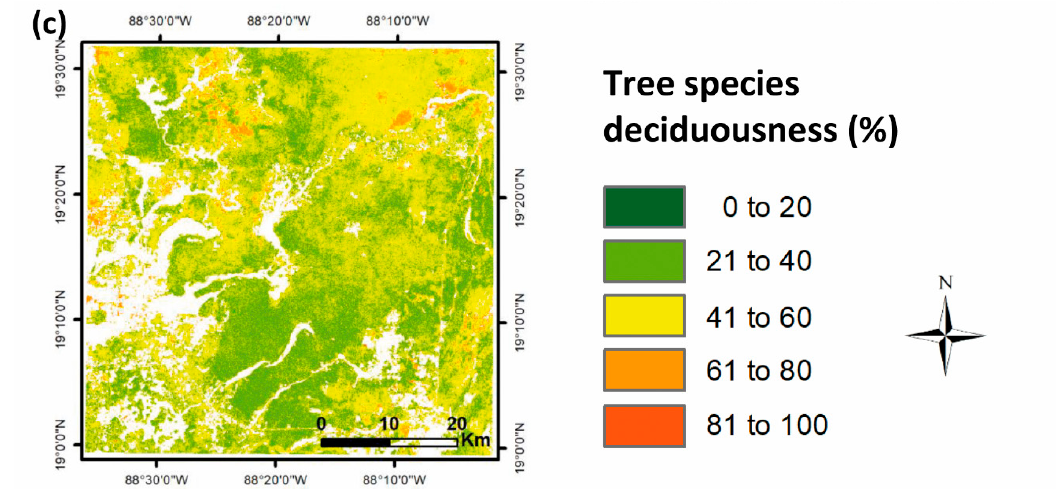
Figure 5. Maps of tree species deciduousness for each vegetation type: ( a ) deciduous (El Palmar), ( b ) semi-deciduous (Kaxil Kiuic), and ( c ) semi-evergreen (Felipe Carrillo Puerto: FCP). Areas in white correspond to non-forest covers, mostly agricultural lands and human settlements.